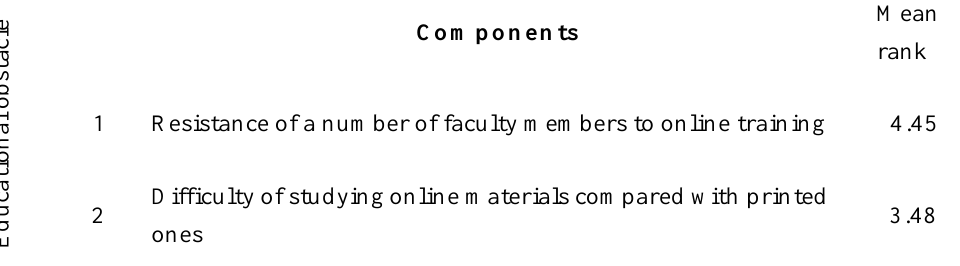
Ranking of the Six Components within the Educational